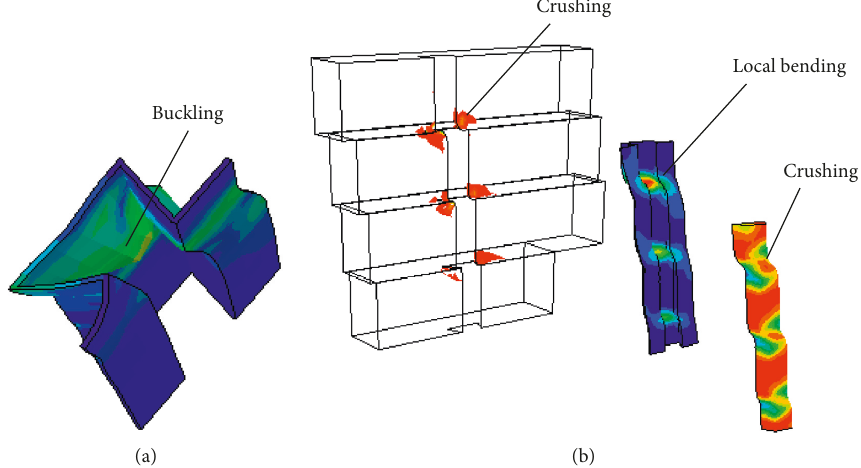
Figure 7: FE numerical response of (a) M01 and (b) M02 specimens, at an imposed displacement of 40mm (ABAQUS). Component